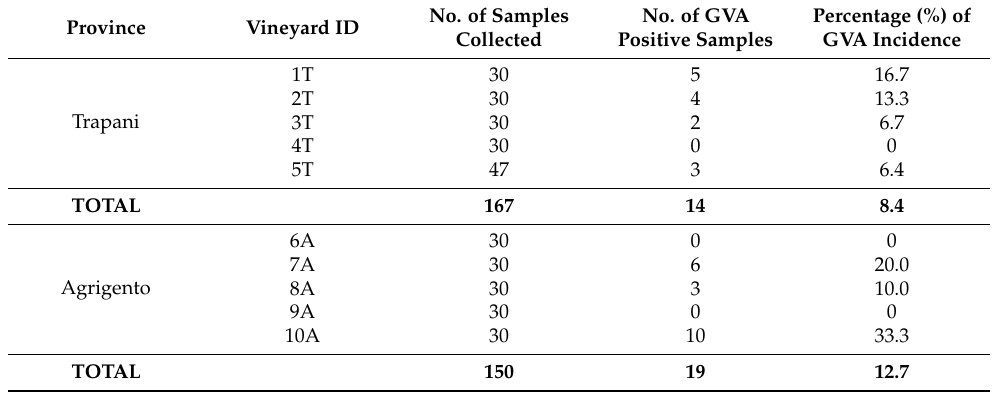
Table 3. Number of samples collected and incidence percentage of Grapevine virus A for each